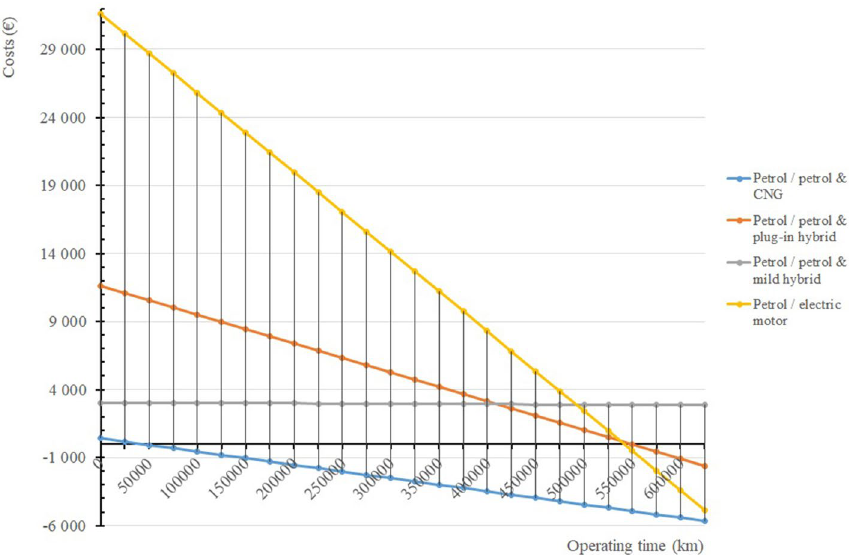
Figure 7. The course of return on investment when purchasing an alternative car depending on the kilometres travelled t o